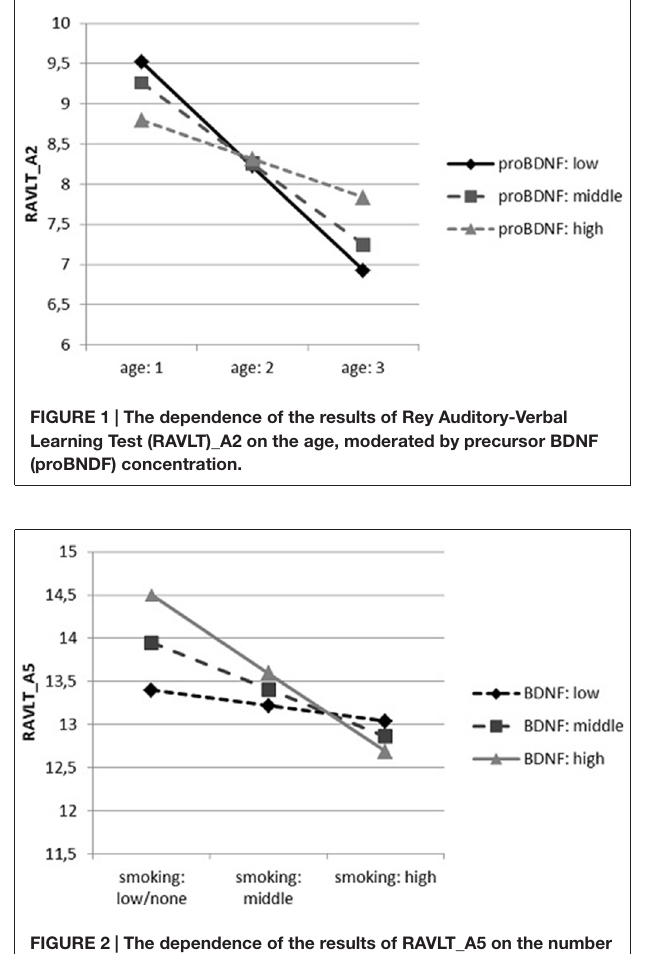
FIGURE 2 | The dependence of the results of RAVLT_A5 on the number of cigarettes smoked per day, moderated by mature BDNF (mBDNF) concentration.